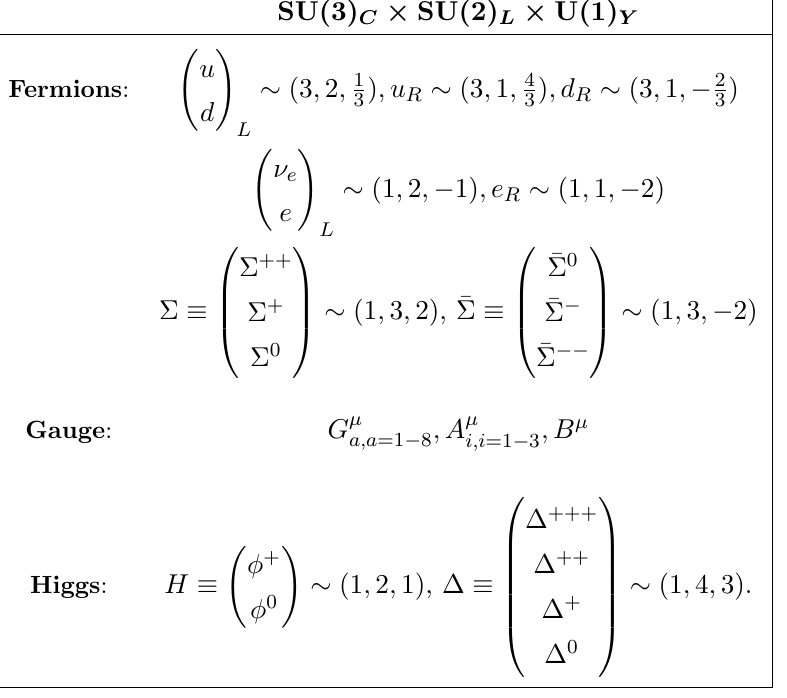
Table 1 . Fermion, gauge and Higgs contents of the